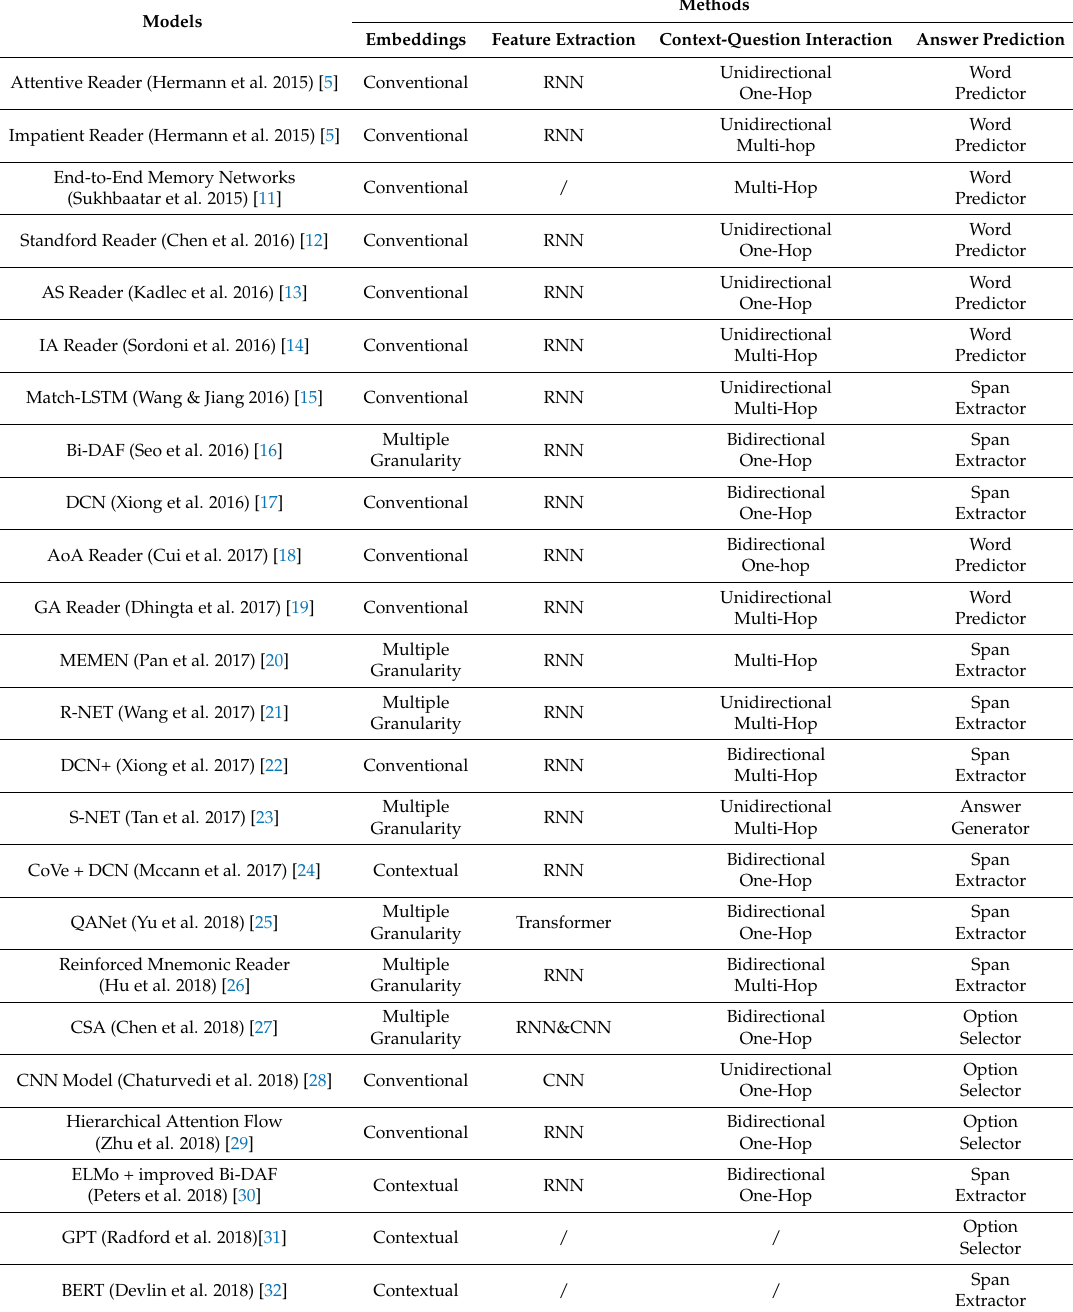
Table 7. Classic neural MRC models (C: Cloze Tests, M: Multiple Choice, S: Span Extraction, F: Free